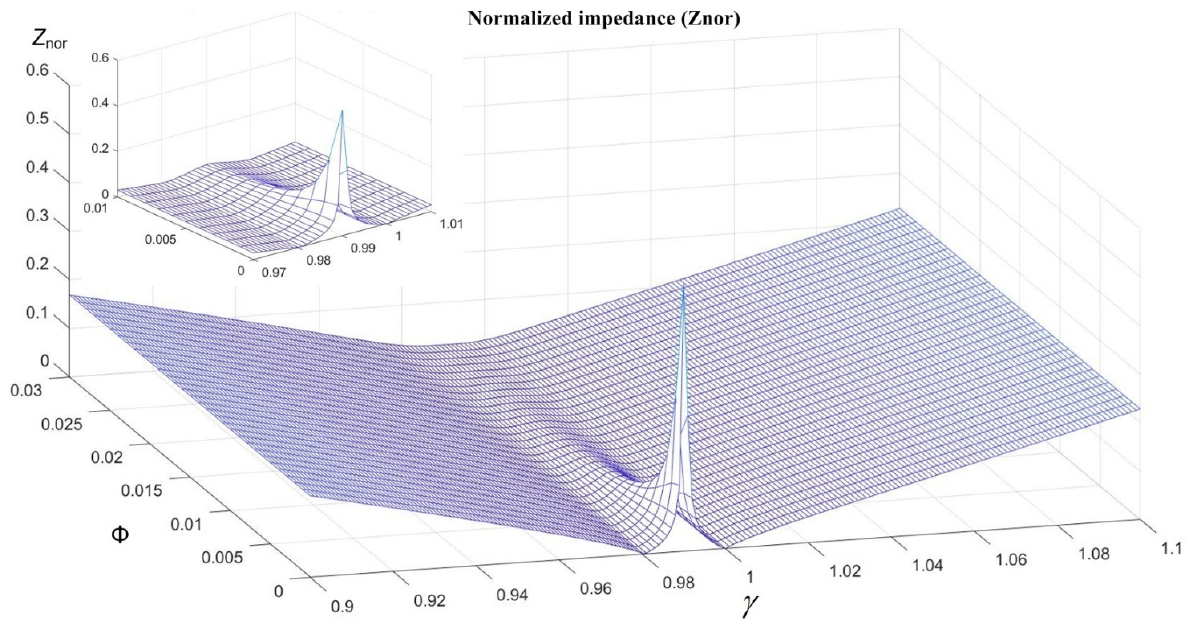
Figure 7. Normalized impedance in the function of γ , ϕ , and m = 50.